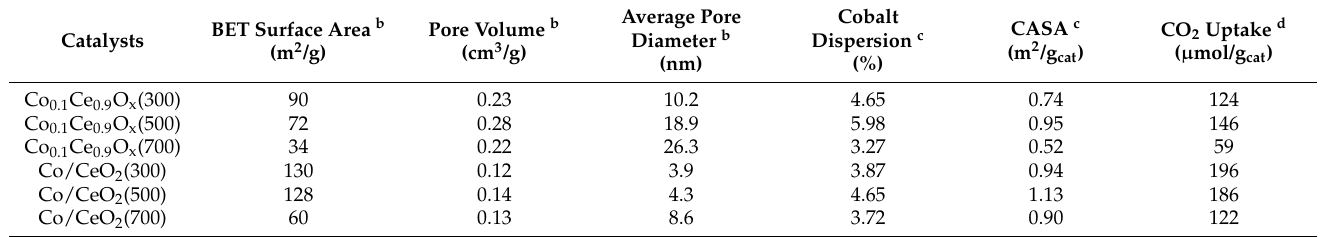
Table 1. Physicochemical properties of ceria-supported cobalt catalysts a